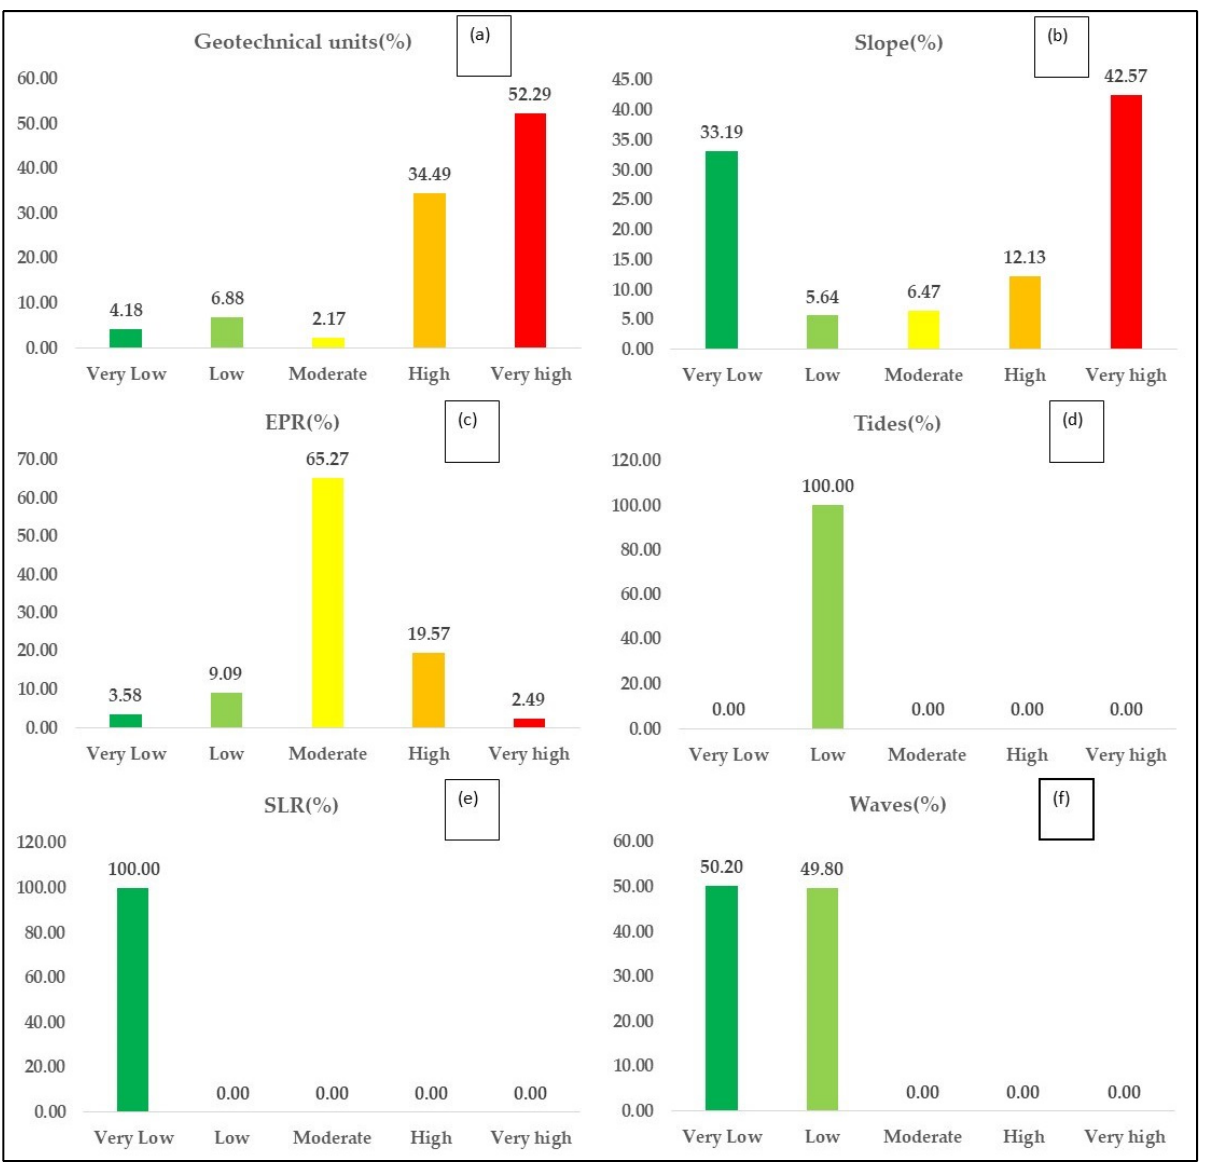
Figure 4. Vulnerability characterization in percentage (%) along the coastline of the pilot area for each of the variables used in the CVI calculations.